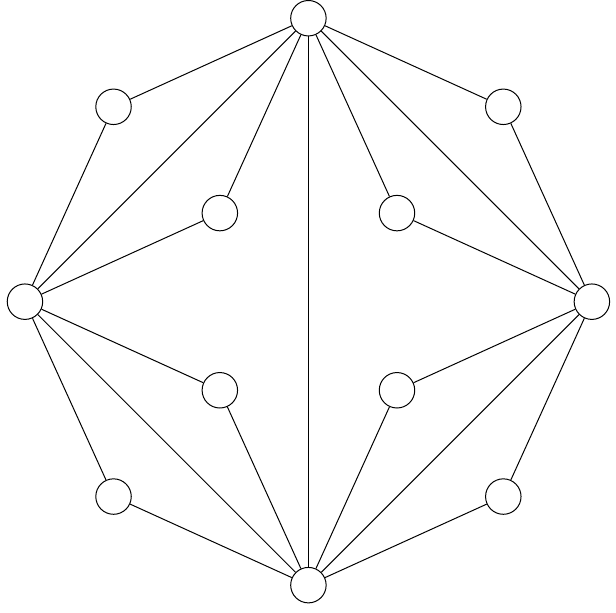
2 , the edges of intermediate length